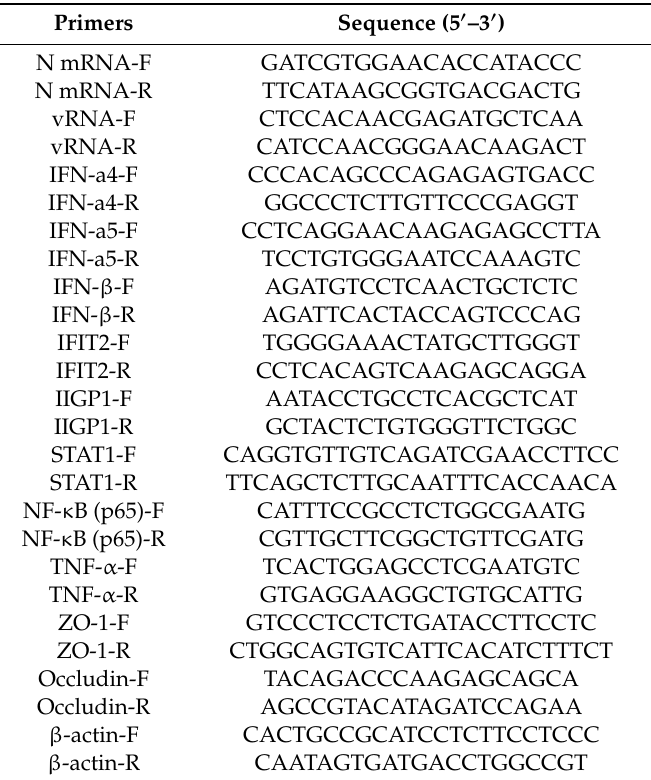
Table 2. Primers for